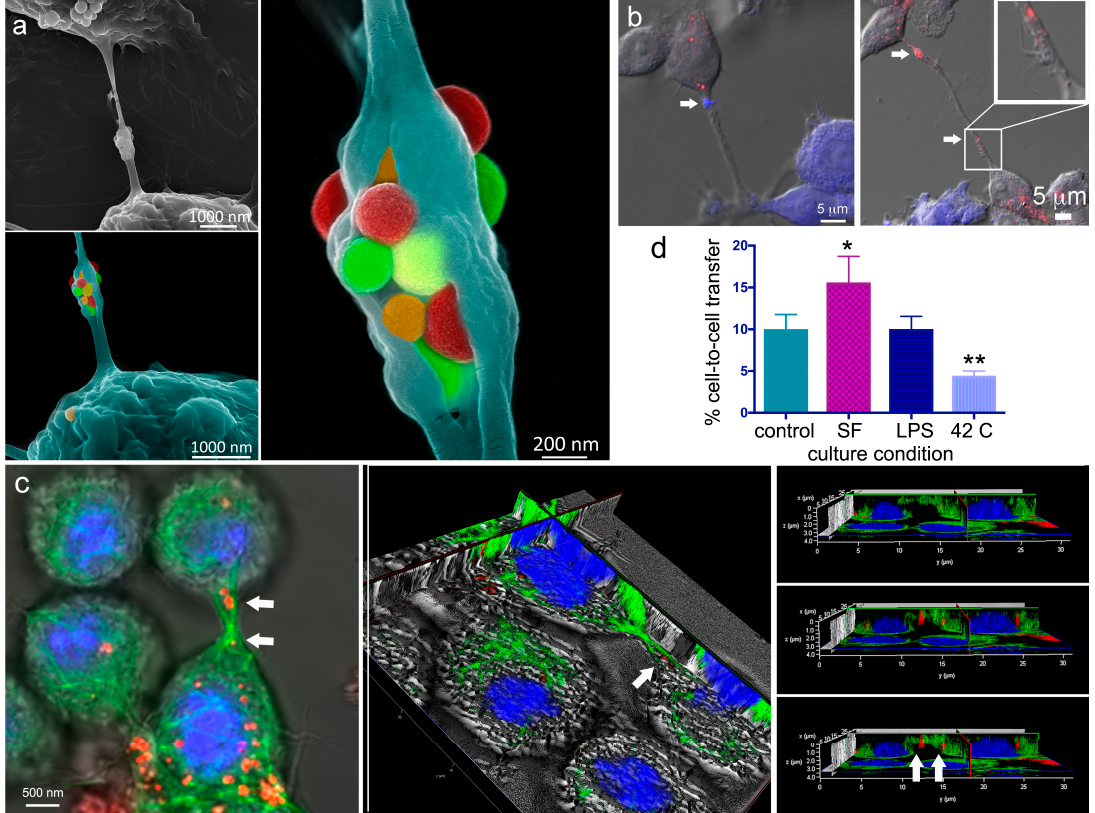
Figure4. HomotypicMSNtransferbetweenRAW264.7macrophages. ( a )Grayscaleandpseudo-colored scanning electron micrographs at three levels of magnification showing false-colored MSN present in a split gondola connecting two macrophages. ( b ) Merged di ff erential interference contrast (DIC) and confocal images of macrophages co-cultured for 24 h after one population was labeled with CellTracker Blue (blue) and the other with DyLight 594 MSN (red). ( c ) Confocal, sectioned, and 3D orthogonal images of macrophages, 5 h following the addition of MSN (red) to the cell media [DIC; Alexa Fluor 488 α -tubulin; DyLight 594 MSN; and nuclei (DAPI, blue)]. The α -tubulin (green) formed cytoskeletal bridges between cells that MSN (red; arrows) utilized to traverse from one cell to another. ( d ) Flow cytometry analysis of relative DyLight 594 MSN transfer from preloaded macrophages to CellTracker Violet positive macrophages under control (NTC), serum-free (SF), lipopolysaccharide (LPS), or hyperthermic (42 ◦ C) conditions. (* p < 0.05; ** p <